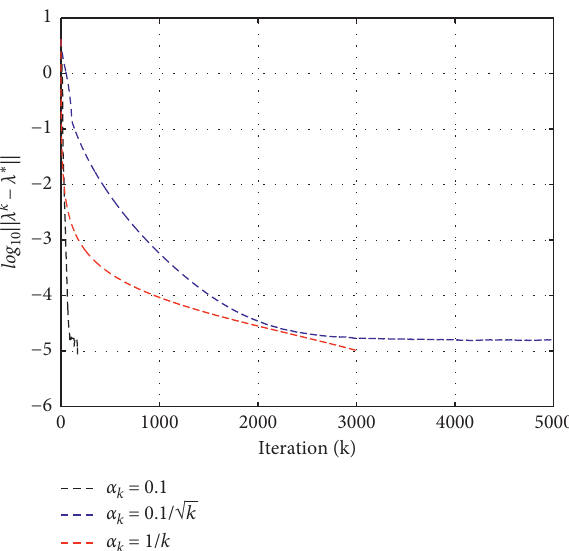
Figure 9: Convergence of log ‖ λ k − λ ∗ ‖ in the subgradient method with the constant, nonsummable diminishing, and square summable 10 but not summable step size rules. The figure shows a slower convergence using α k � 0 . 1/ diminishing and square summable but not summable step size rules, respectively.